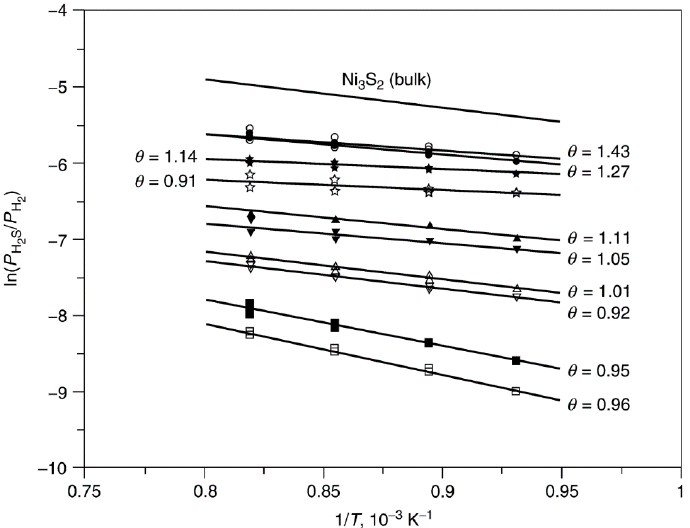
Figure 6. A series of in situ scanning tunneling microscope (STM) images recorded after exposure of Ni(110) to oxygen and then progressively higher exposures of H 2 S: ( a ) (2 × 1)O overlayer; ( b ) white islands and black troughs with a c(2 × 2)S structure after exposure to 3 and 8 L of H 2 S; ( c ) 25 L, islands transform to low-coordinated rows in the [001] direction; and ( d ) 50 L, stable, well-ordered (4 × 1)S. Reproduced from [40]. Copyright 1992, American Physical Society.